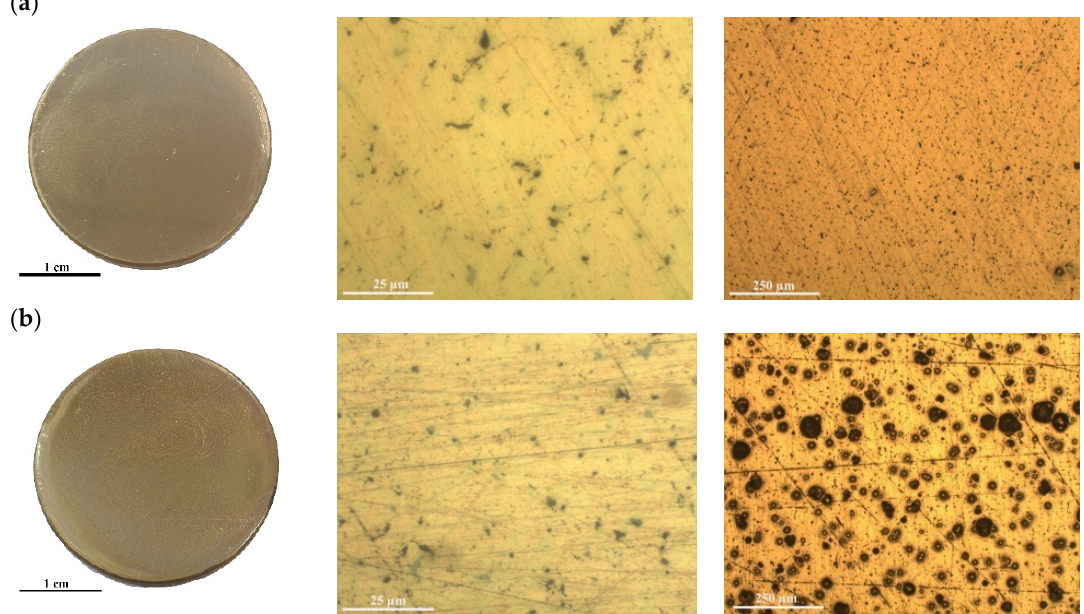
Figure 7. General appearance and OM micrographs of the Cu-based alloy coated with a thin chitosan film with CH/Cy 0.25 mg/mL after accelerated corrosion treatments were carried out for 180 min and 250 min, ( a , b ), respectively. For both examples, the scale bar corresponds to 25 μ m for the high magnification image and 250 μ m for the low magnification, at the center and on the right, respectively.